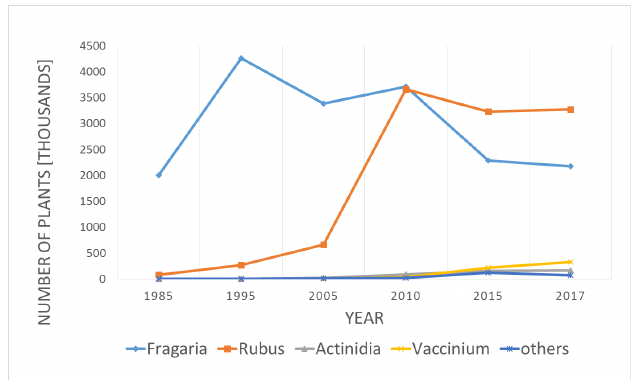
Fig. 4: Plant production numbers of small fruit species from 1985 to 2017 (stated by ADIVK members, voluntary